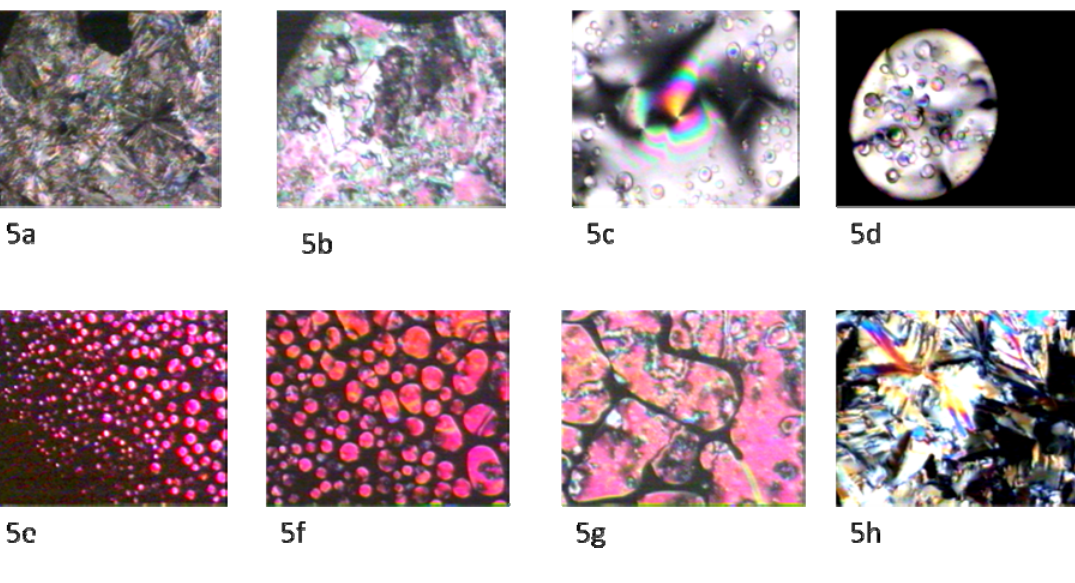
Figure 5. (5a) Crystalline texture of the mesogen; crossed polarizers, 25 ° C, × 150. (5b) Nematic texture; crossed polarizers, 77.3 ° C, × 150. (5c).Nematic–Isotropic transition; crossed polarizers.176 ° C, × 150. (5d) . Nematic –Isotropic Transition. The black domain is the isotropic phase with no optical activity; crossed polarizers,176 ° C, × 150. (5e) Nematic droplets appear from the isotropic phase; crossed polarizers, 174 ° C, × 150. (5f) Nematic droplets starts to coalesce to form the nematic texture; crossed polarizers, 174 ° C, × 150. (5g) Nematic domain becomes more apparent and threadlike texture is appearing; crossed polarizers, 174 ° C, × 150. (5h) Crystalline texture; crossed polarizers, below 40 ° C, ×